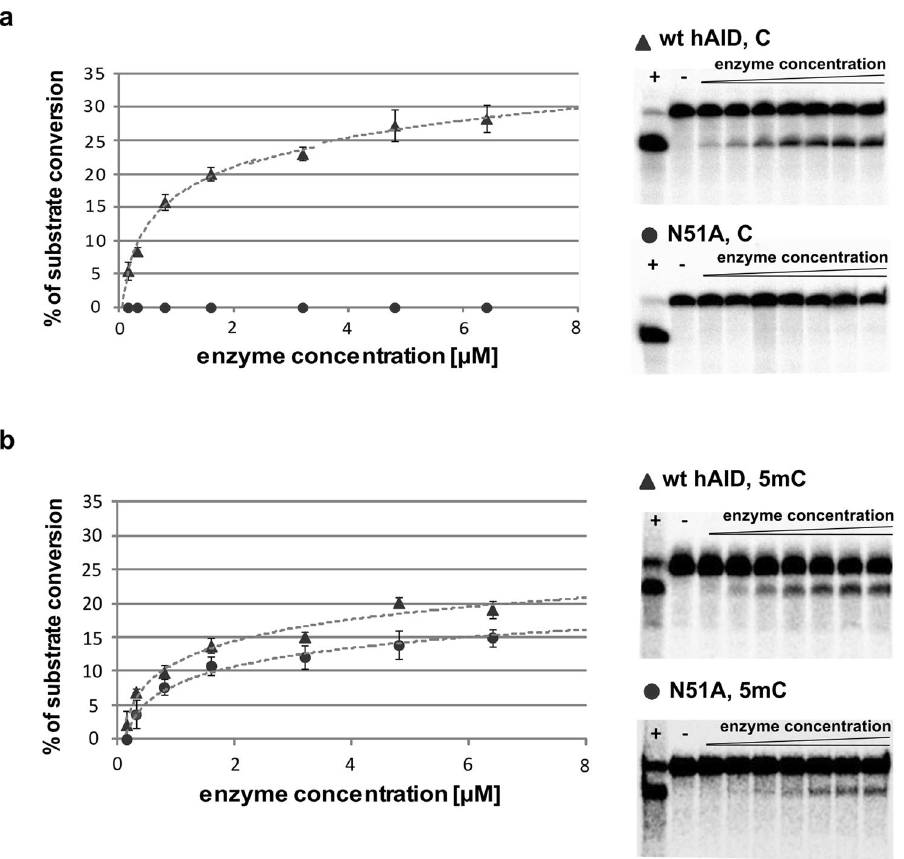
Figure 2. Analyses of enzyme’s concentration-dependent deamination of C ( a ) and 5 mC ( b ) containing substrates by wt hAID and N51A mutant. The graph presents the dependence between the yield of C/5 mC deamination reactions and enzyme concentration (wt hAID (triangles) and N51A mutant (circles)). UDG- coupled and TDG-coupled deamination assays (see Methods) were used for C and 5 mC substrates, respectively. Error bars represent standard deviation from the mean of at least three independent replicates. Representative PAGE analyses of the products of deamination reaction are shown on the right. Positive and negative control reactions are indicated by “ + ” or “ − ”, respectively. The cropped gel images are displayed. Full-length gel images are shown in Supplementary Fig.